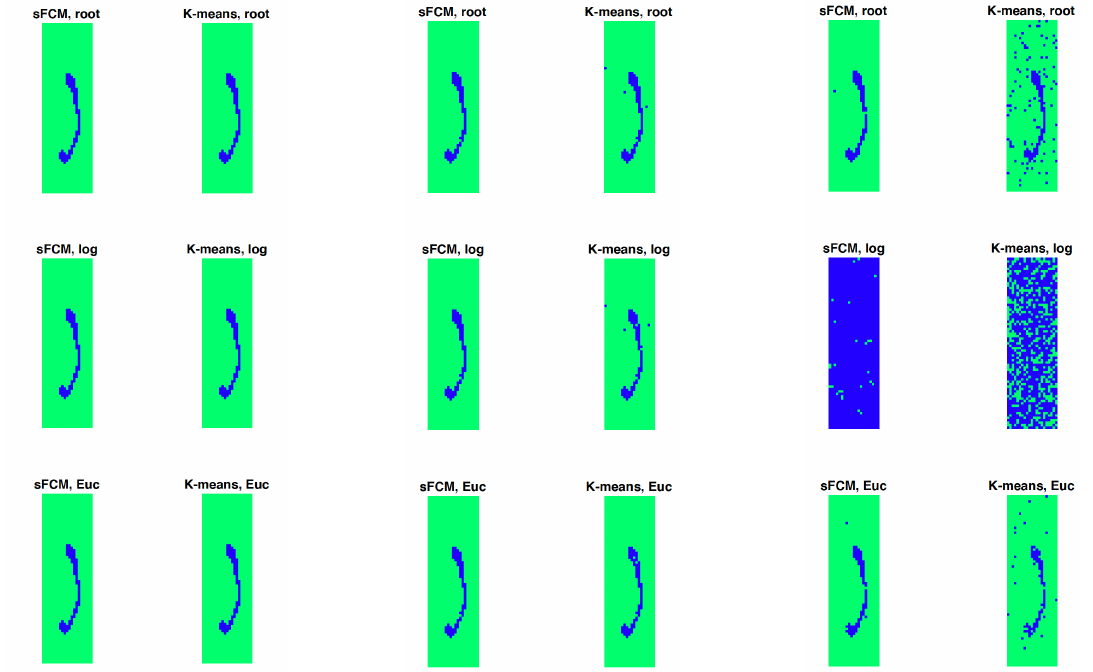
Figure 5. Segmentation after adding three levels of